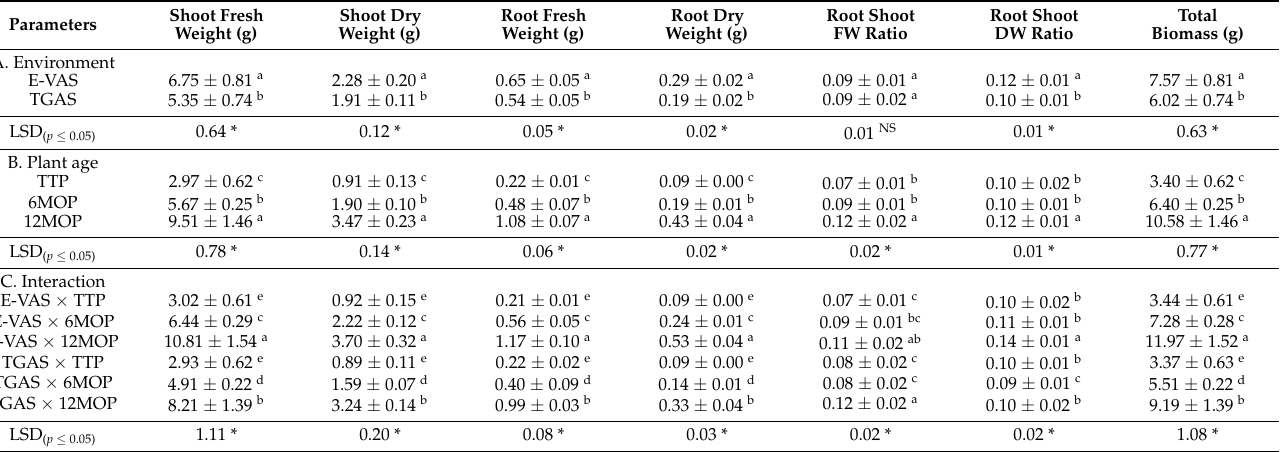
Table 3. Plant biomass response of different-aged tissue culture-derived date palm (cv. Khalas) plants under ex vitro acclimatization system (E-VAS) and traditional glasshouse acclimatization system (TGAS) environment for acclimatization.